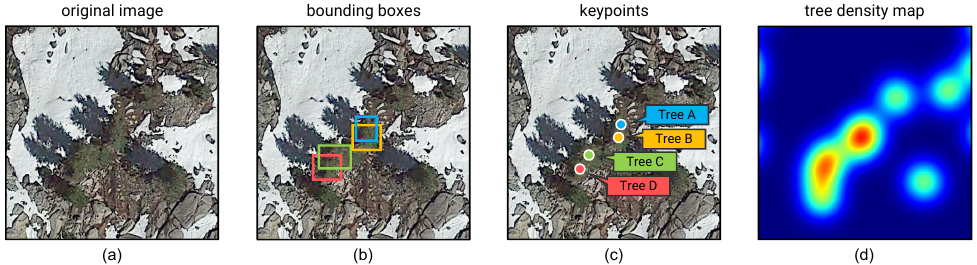
Figure 1. Comparison among different types of annotations for tree counting methods. ( a ) The original image. ( b ) Bounding boxes. ( c ) Keypoints. ( d ) Tree density map.